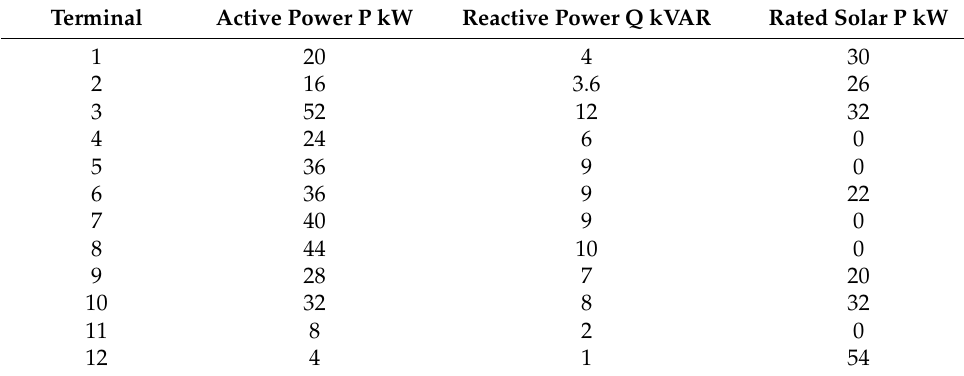
Table 5. Terminal rated peak active power, reactive power, and solar generation